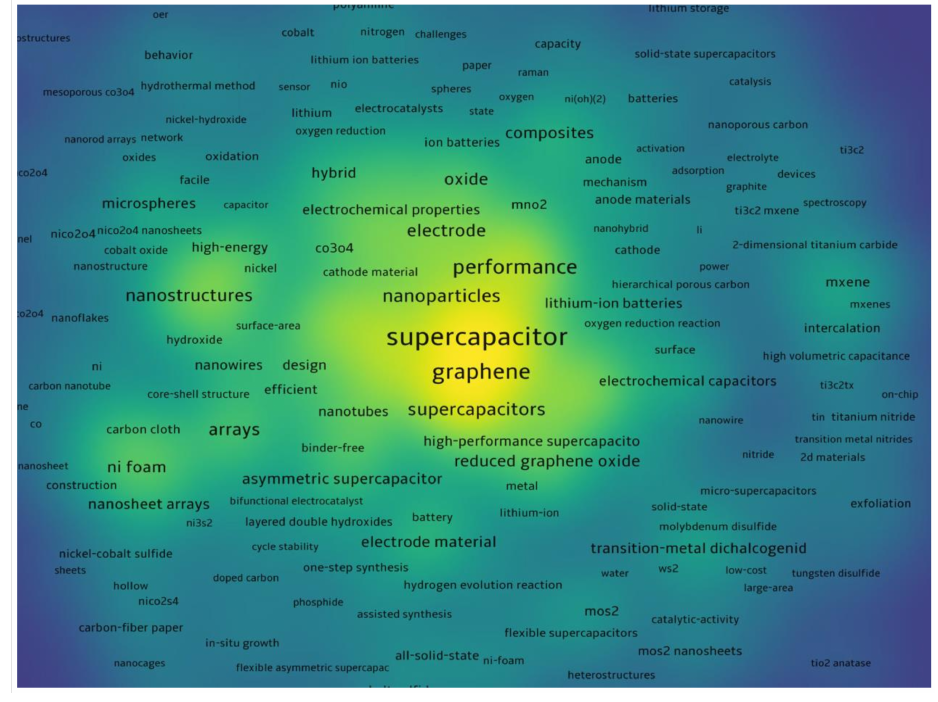
Figure 18. Bibliometric density mapping of the SC research field in the last five